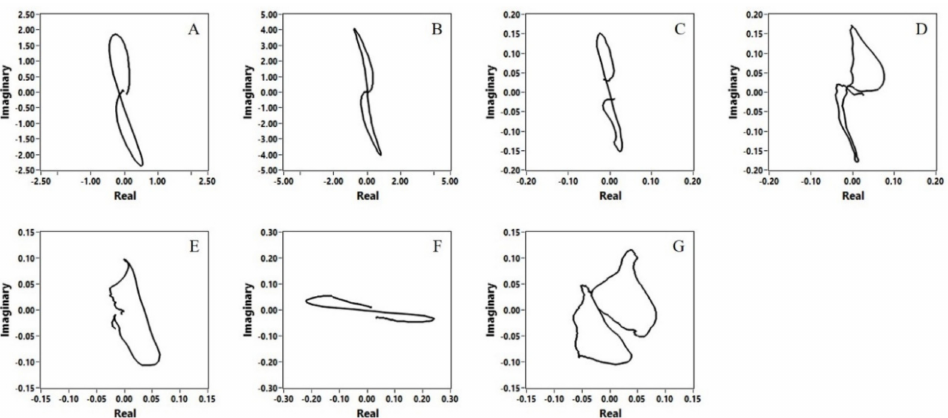
Figure 7. Lissajous curves from the front bobbin coils for the specimen with di ff erent type flaws (150 kHz AC).